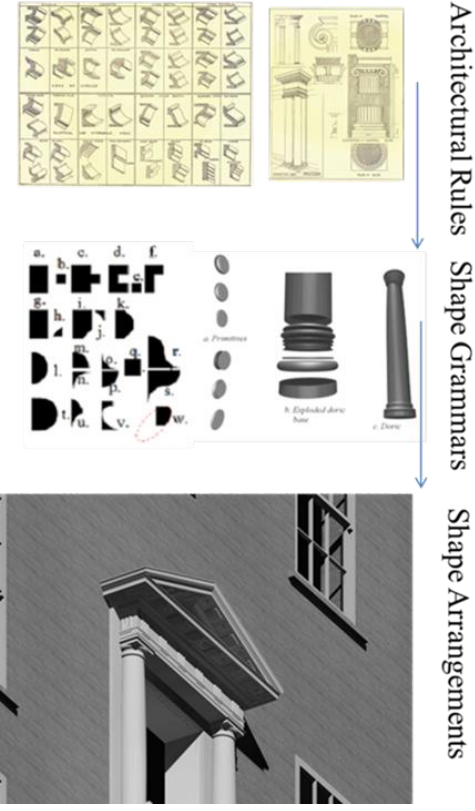
Figure15. Applied Shape Grammars to Classical